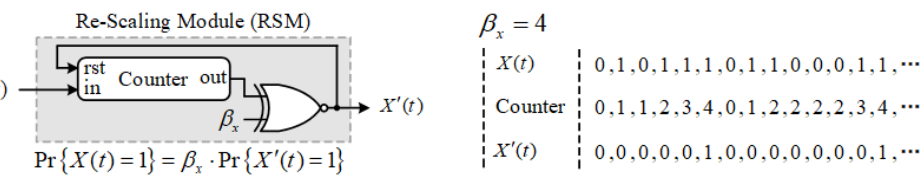
Figure 7. Hardware architecture of re-scaling modules.